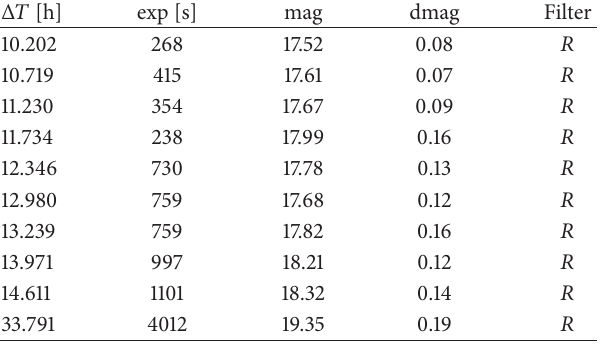
Table 10: GRB 100901A: observing log of BOOTES-2.